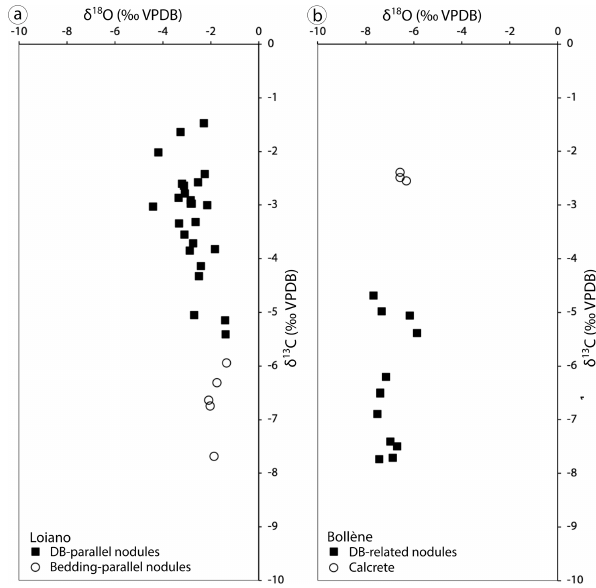
Figure 12. Stable isotope analysis results. (a) Cumulative isotopic data characterizing the DB-parallel nodules (black full dots) and bedding-parallel ones (empty dots) inside the Loiano Sandstones. (b) Isotopic data from the DB-related nodules (black full dots) and cement sampled in the calcrete (empty dots) in the Bollène quarry (see the Supplement S2 for